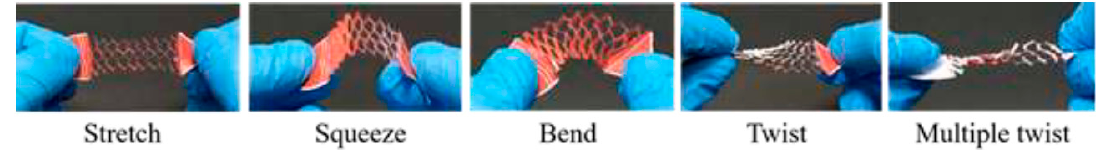
Figure 5. Patterned paper fish under various mechanical stresses. Reproduced from [32] with permission. Copyright 2018 WILEY-VCH Verlag GmbH & Co. KGaA, Weinheim.